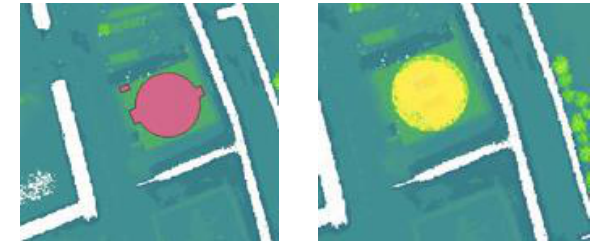
Figure 4. The BAG building on the left has no height, because